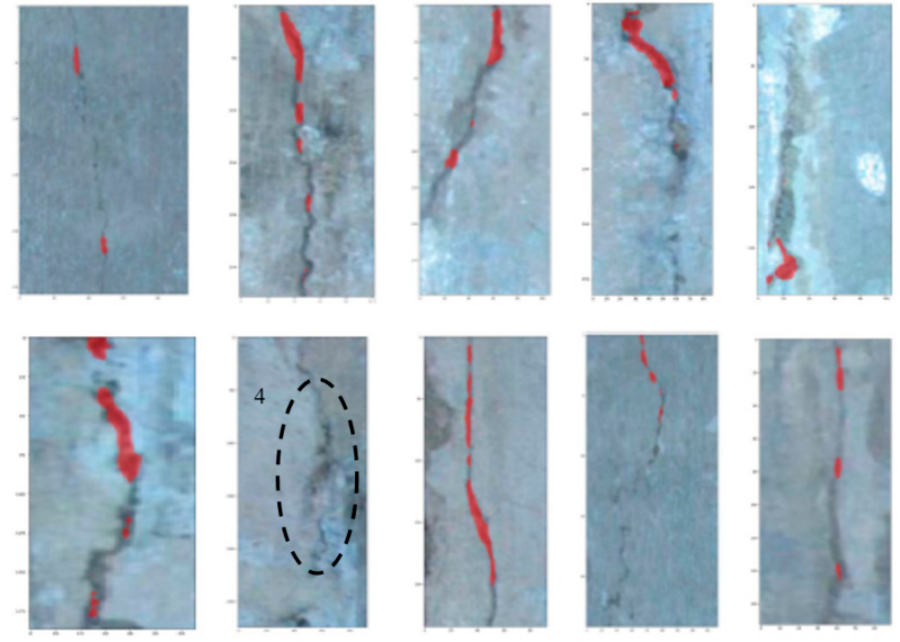
Figure 7. The testing dataset of cracks.